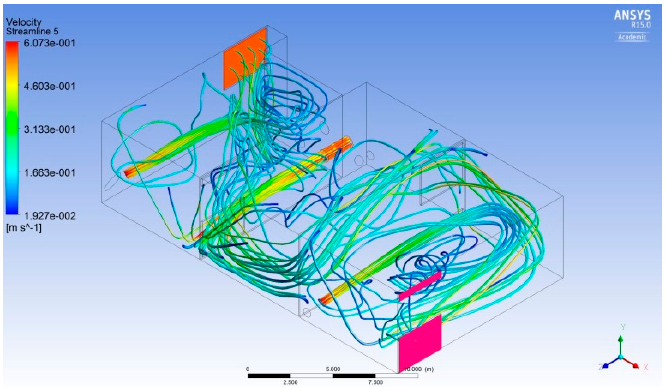
Figure 12. Streamline path plot of reduced mixer duration.